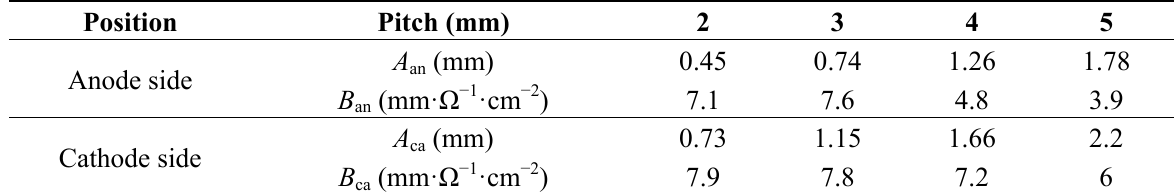
Table 8. Parameters for the optimal rib width.